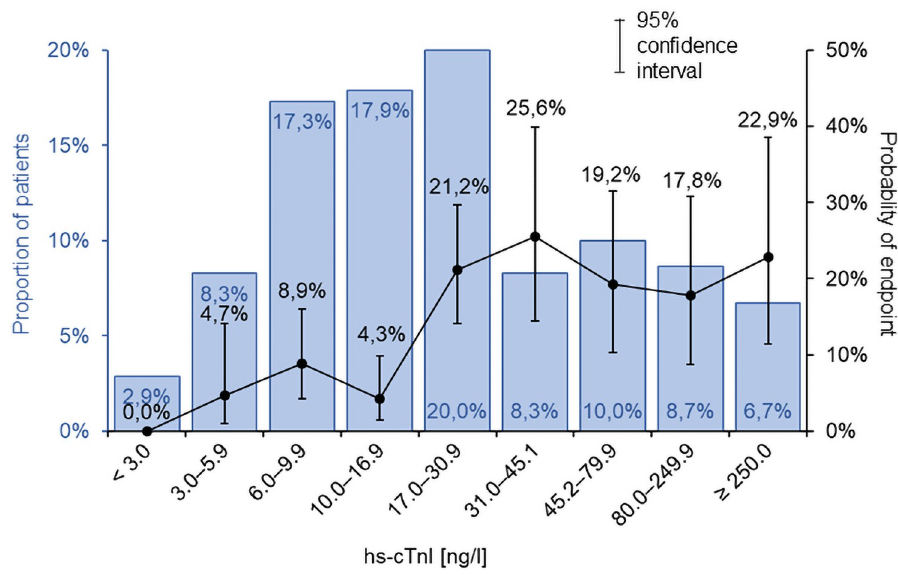
Fig 1. hs-cTnI distribution in patients with chronic heart failure and the associated 2-year occurrence of the combined endpoints (death, HTX or LVAD).